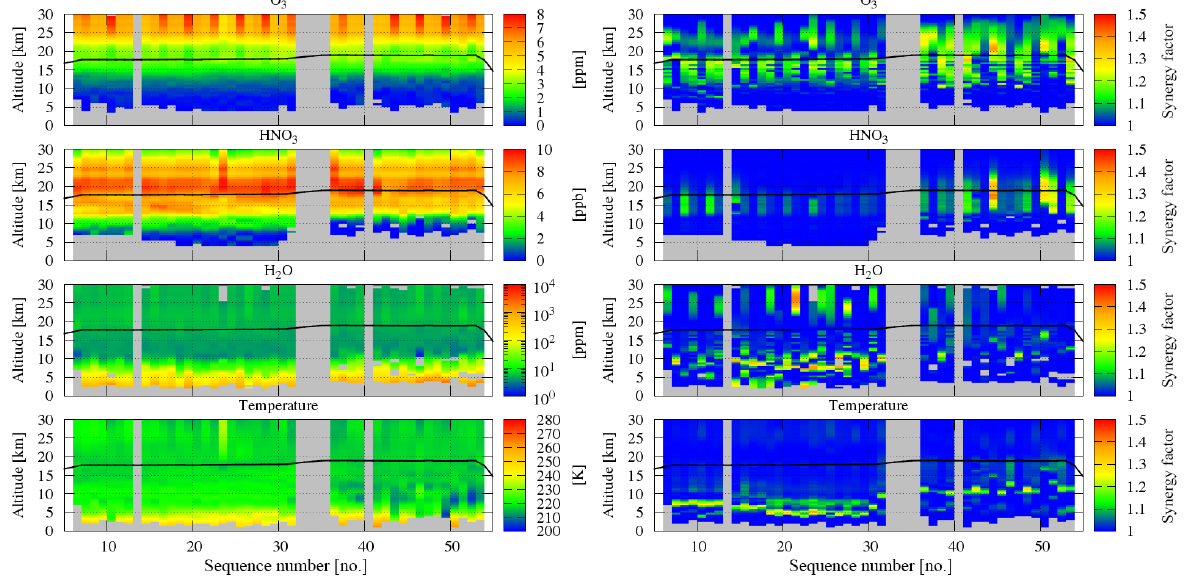
Figure 9. MSS data fusion products (left panel) and SF (right panel) for the atmospheric targets as resulting from MSS individual retrievals and MSS data fusion of MARSCHALS and MIPAS-STR limb sounding